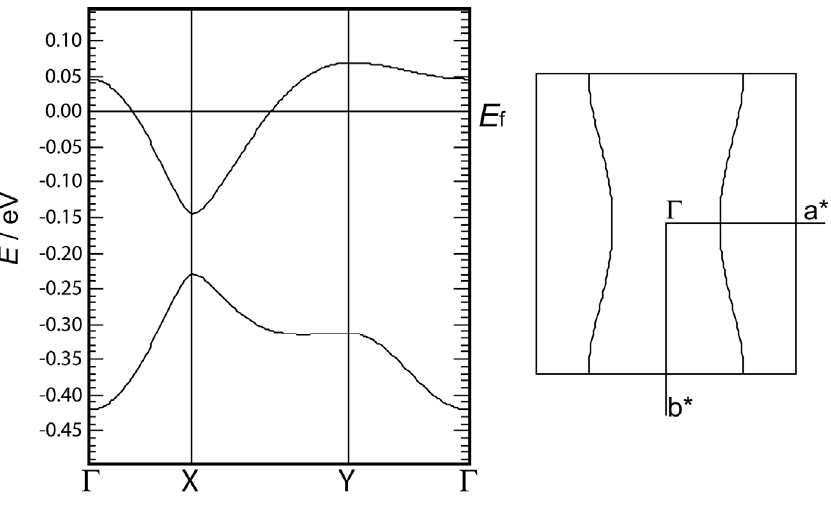
Figure 3. Calculated energy band structure and Fermi surface of 1